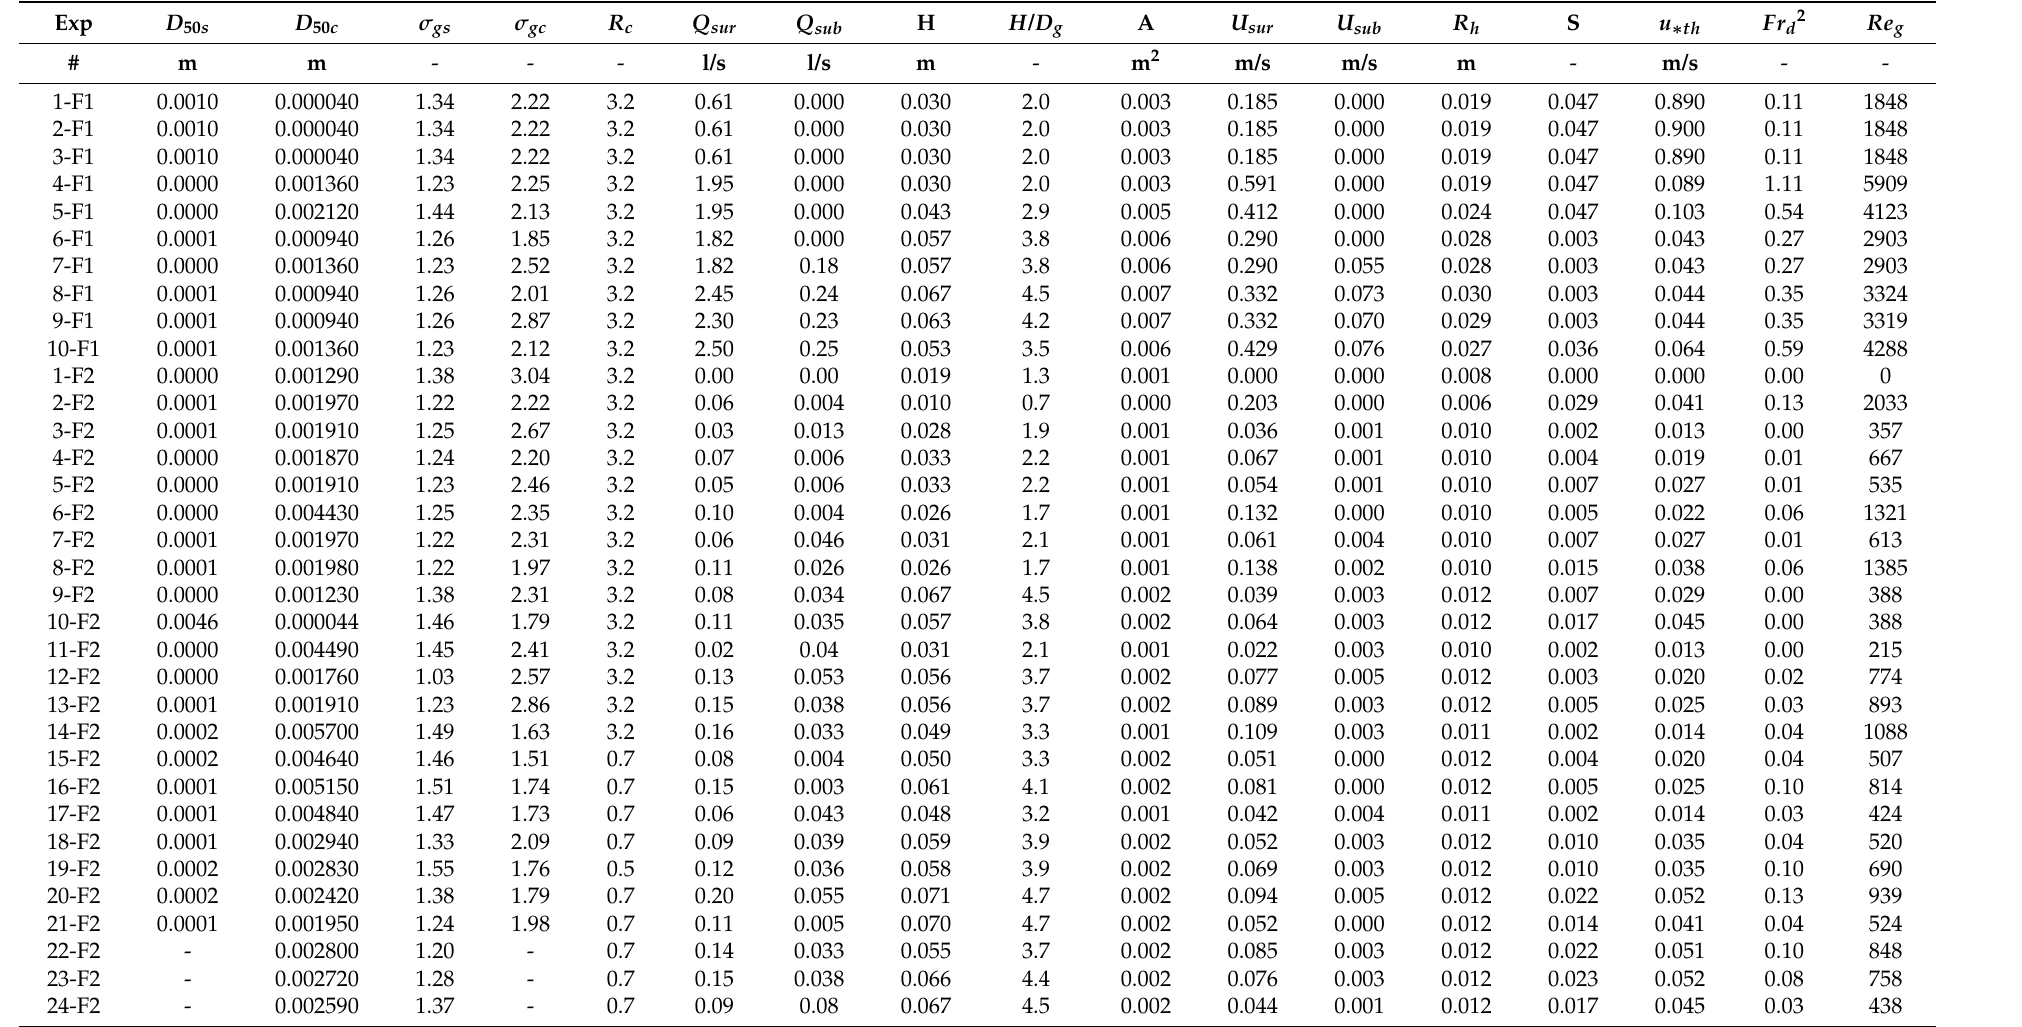
Table 1. Sediment, mineral particles, and hydraulic parameters of flume, F1, and sediment column experiments,